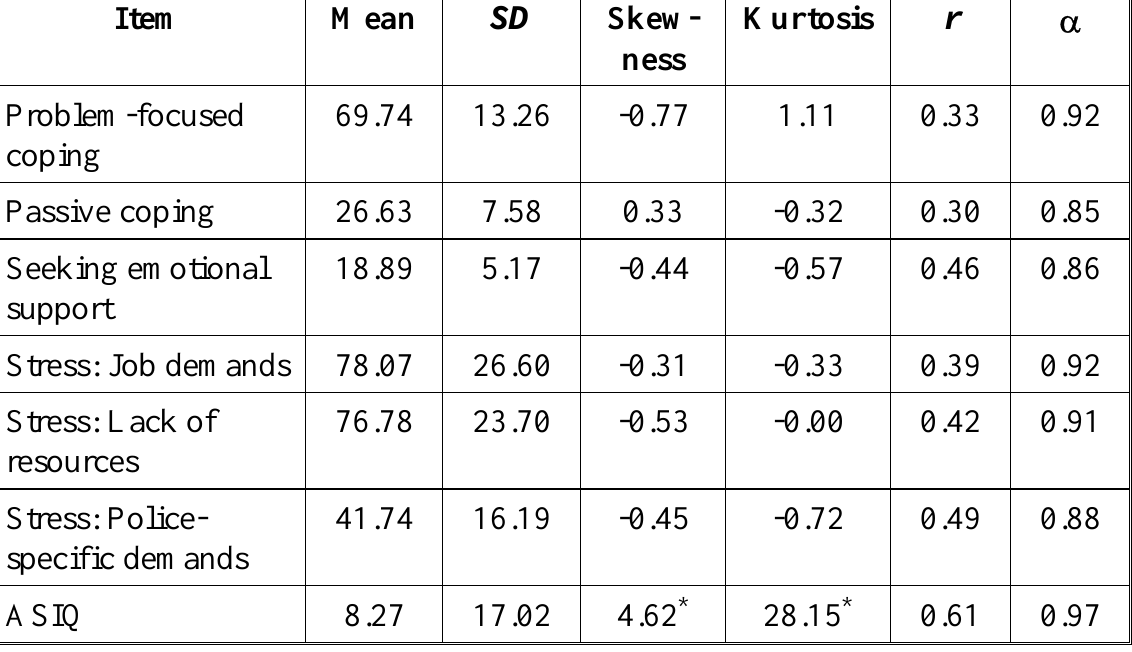
Descriptive statistics, Cronbach Alpha coefficients and inter- item correlation coefficients of the measuring